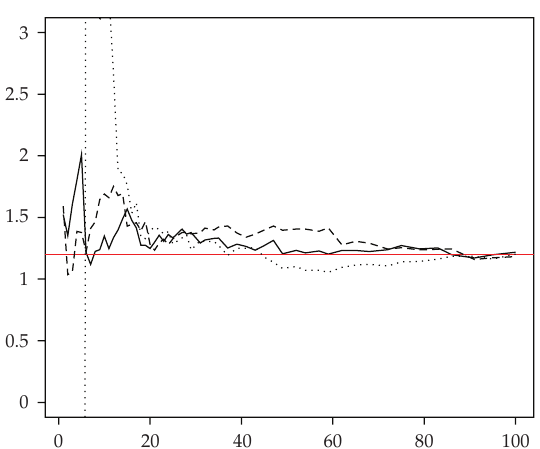
Figure 3: Plots of Hill estimators, as functions of the number of extreme statistics, (cid:5) α (cid:2) solid line (cid:3) , (cid:5) α R (cid:2) dashed line (cid:3) and (cid:5) α L (cid:2) dotted line (cid:3) of the characteristic exponent α of a symmetric stable distribution, based on 1000 observations with 50 replications. The horizontal line represents the true value of α (cid:4) 1 . 2.